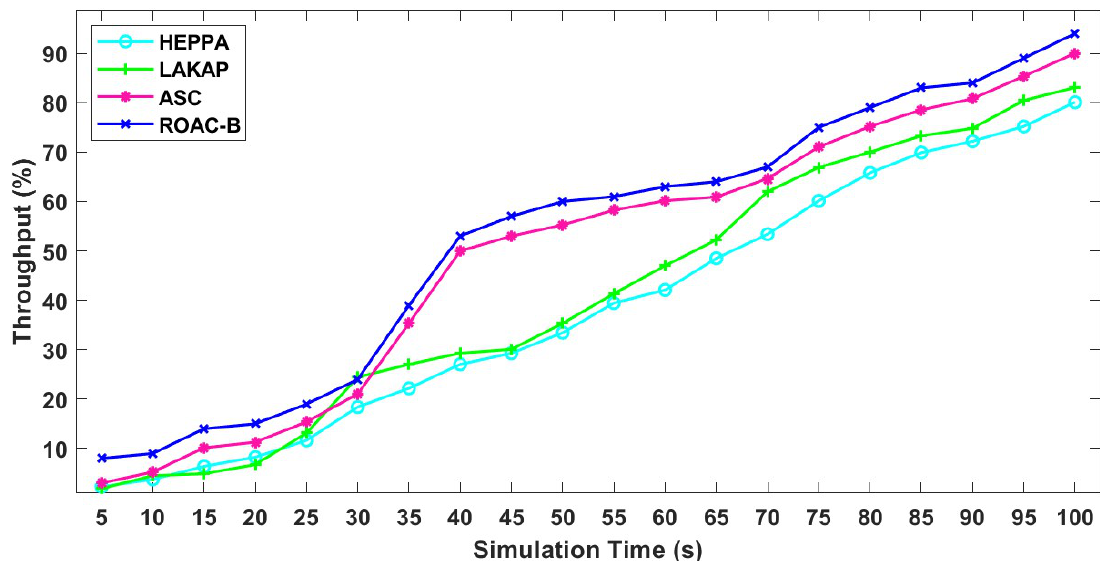
Figure 9. Throughput analysis of ROAC-B technique under a denial of service attack.